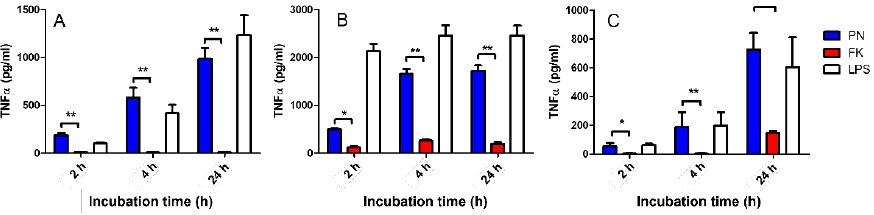
Figure 2. Macrophage response to whole inactivated bacteria. J774 cells ( A ), U937 cells ( B ), and MH-s cells ( C ) were incubated with formalin (FK)- or peroxynitrite (PN)-neutralized F. tularensis LVS bacteria. Macrophage activation was quantified by TNF α secretion into the media. E. coli LPS (LPS) was used as a positive control; (*) p < 0.05, (**) p < 0.01.